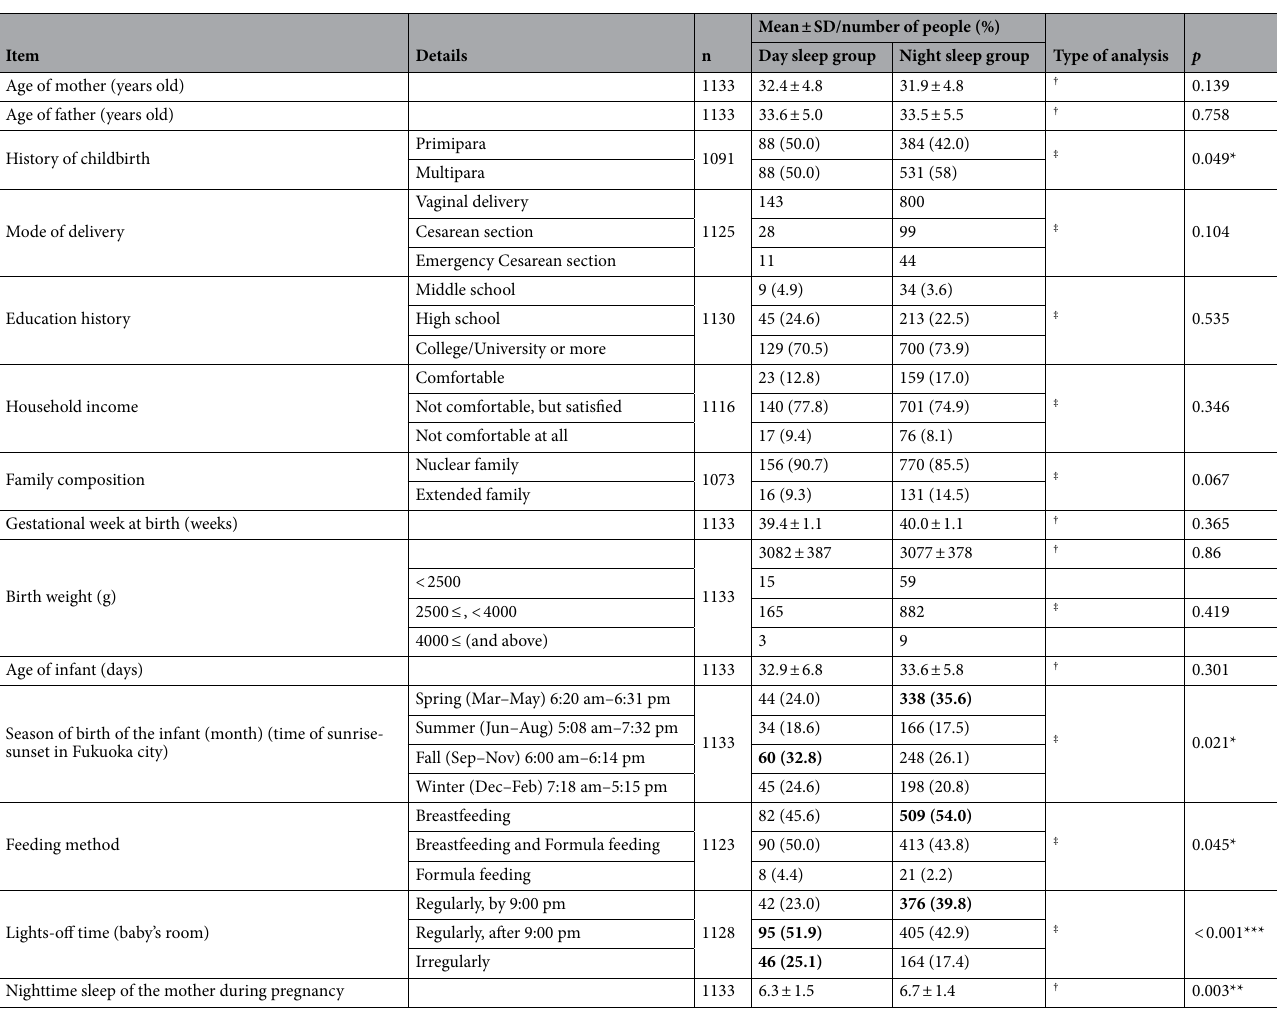
Table 2. Characteristics of day sleep group and night sleep group. † Mann–Whitney U ; ‡ Chi-squared test; * p <